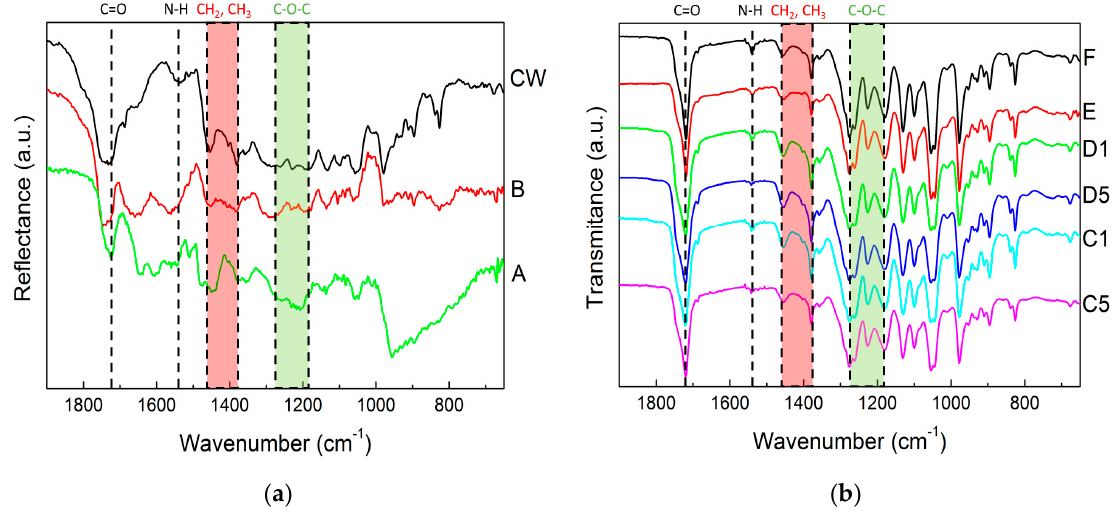
Figure 4. DRIFT spectra of pellets recovered from the digestion with NaOH compared to an MMW PHA produced from cheese whey and digested with NaClO (CW) ( a ) and FTIR spectra of films recovered from extraction in CHCl 3 ( b ).